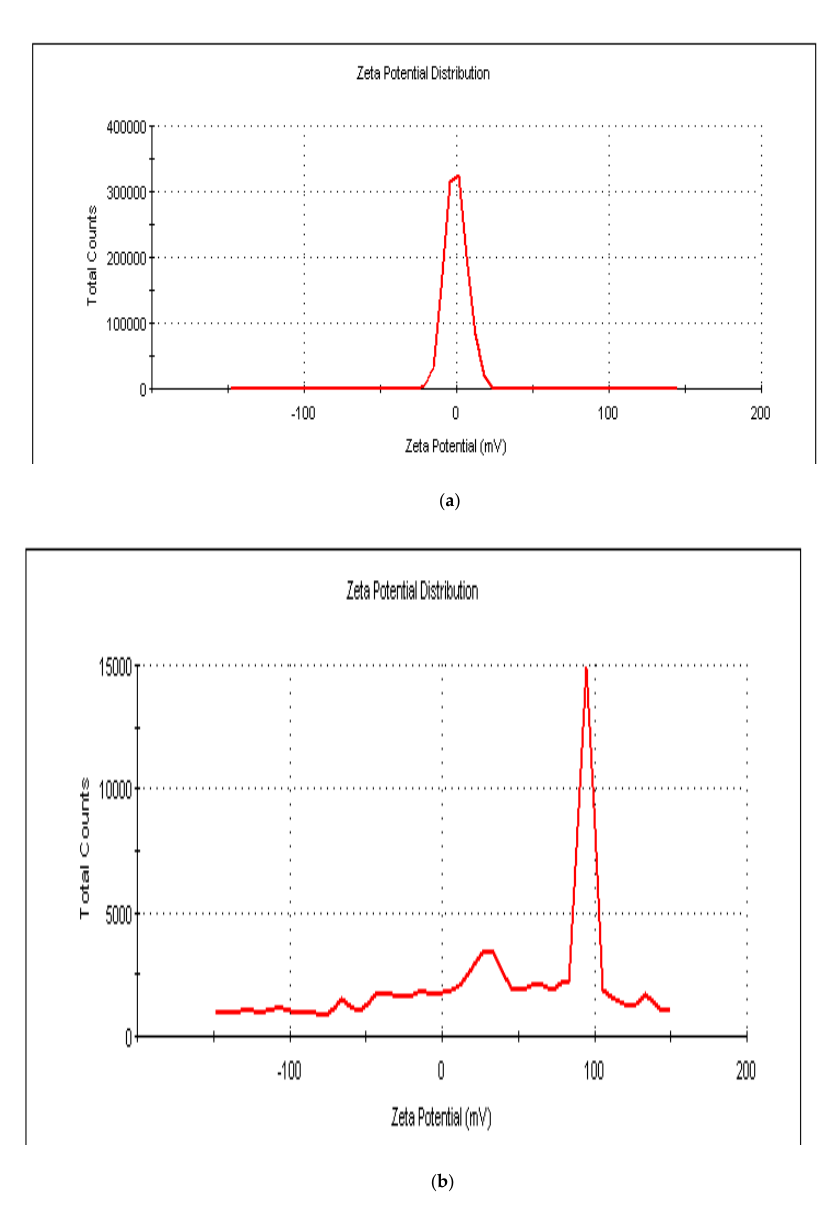
Figure 11. Zeta potential distribution of nano chlorophyll ( a ) and chlorophyll ( b ). Table 1. Chlorophyll A structure variables.